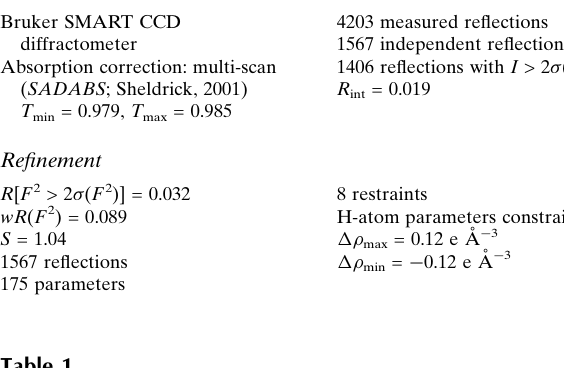
Hydrogen-bond geometry (A˚ , (cid:3)